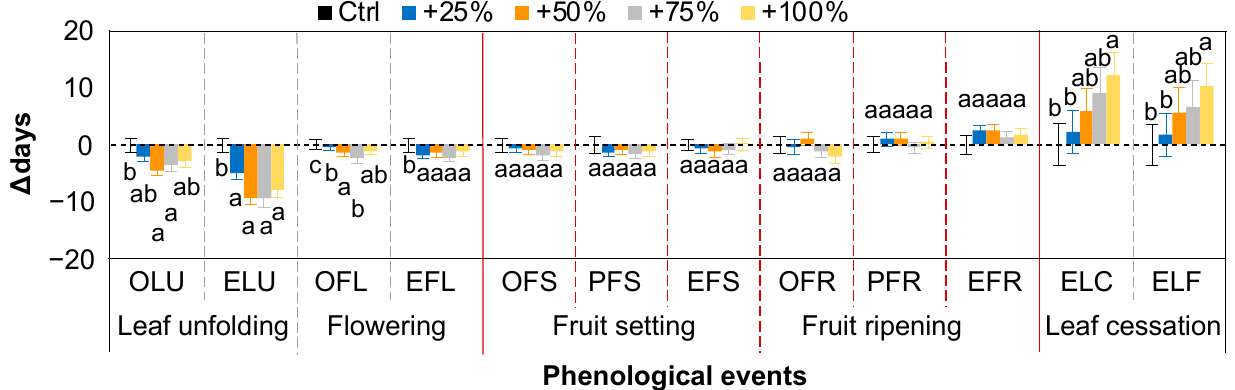
Figure 6 . Comparison of changes ( △ days; mean ± SE) in phenological events of Nitraria tangutorum after water addition treatments (+25%, +50%, +75%, +100%) compared with the control over the period from 2012 to 2018. Fruiting events are between the solid red lines. Positive and negative values represent delayed and advanced days, respectively. OLU, onset of leaf unfolding; ELU, end of leaf unfolding; OFL, onset of flowering, EFL, end of flowering; OFS, onset of fruit setting; PFS, peak of fruit setting; EFS, end of fruit setting; OFR, onset of fruit ripening; PFR, peak of fruit ripening; EFR, end of fruit ripening; ELC, end of leaf coloring; ELF, end of leaf